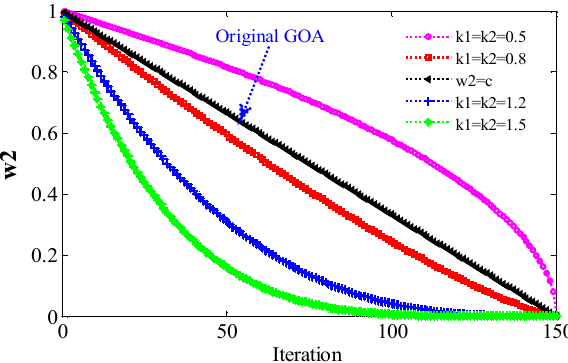
Figure 2. The relationship between ω 2 and parameters k 1, k